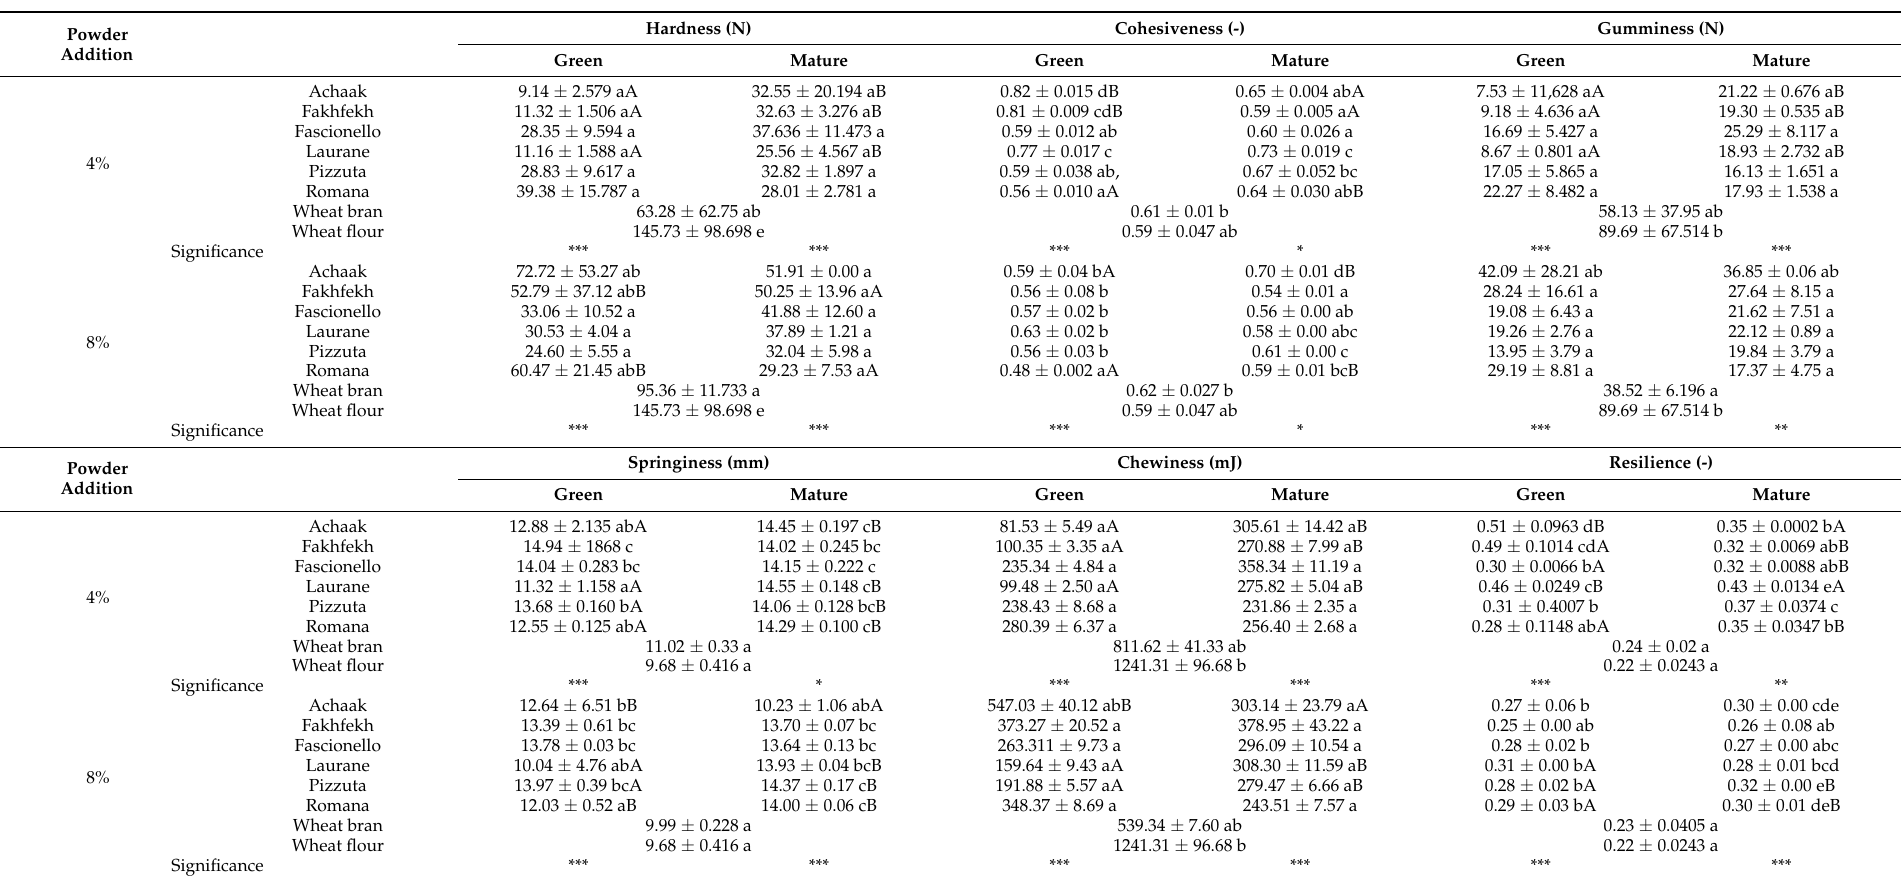
Table 6. Values of texture parameters evaluated on breads and results of variance analysis with Duncan’s test ( p < 0.05) performed between the products and the two harvesting times (green and